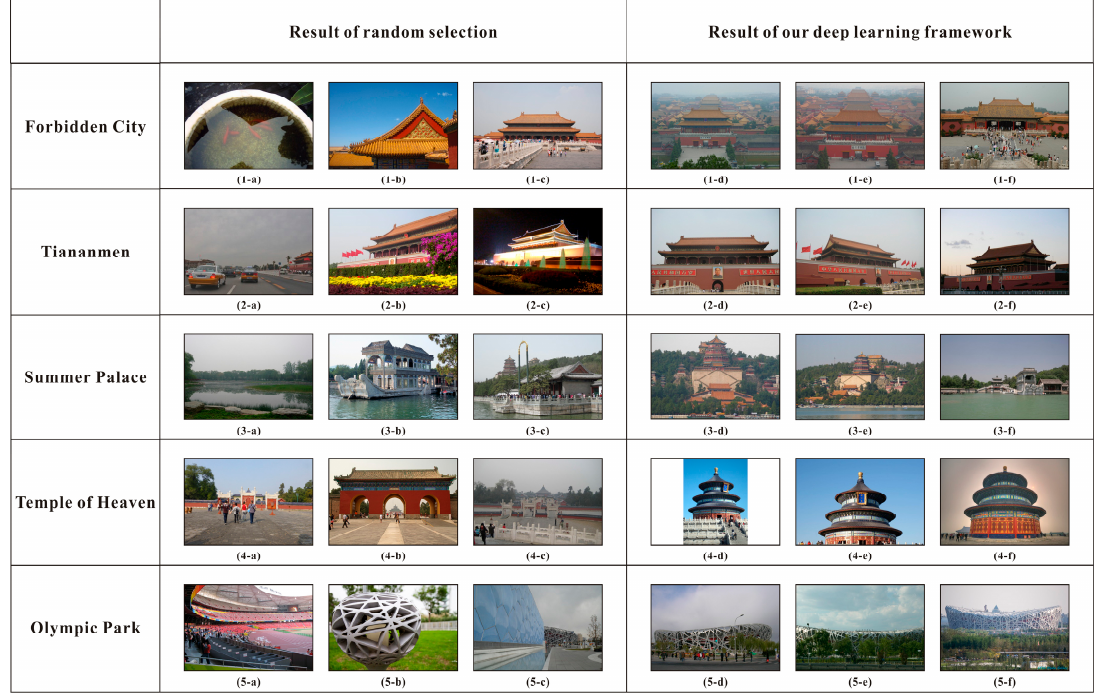
Figure 12. Representative image selection results of random selection and our framework (The photos in Figure 12 are all licensed under the Creative Commons Attribution License).